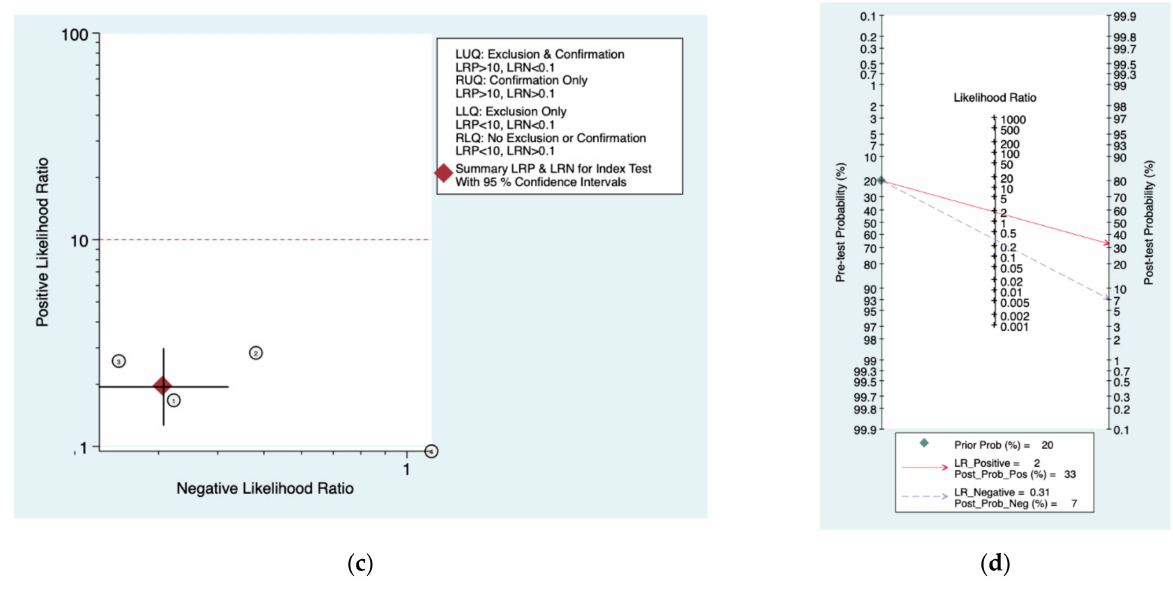
Figure 9. Meta‑analysis of Obholzer protocol. ( a ) Forrest plot of pooled sensitivity and